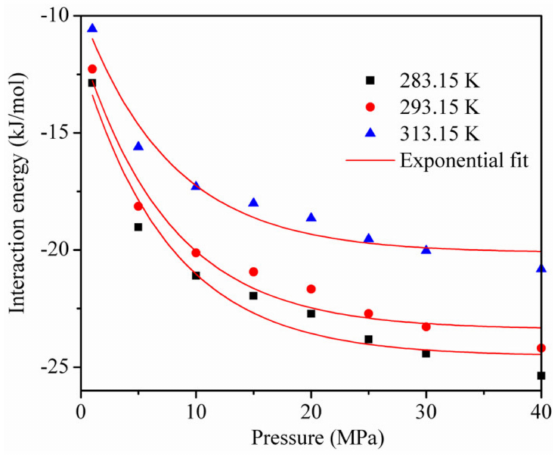
Figure 9. The interaction energy between kaolinite and CO 2 at di ff erent